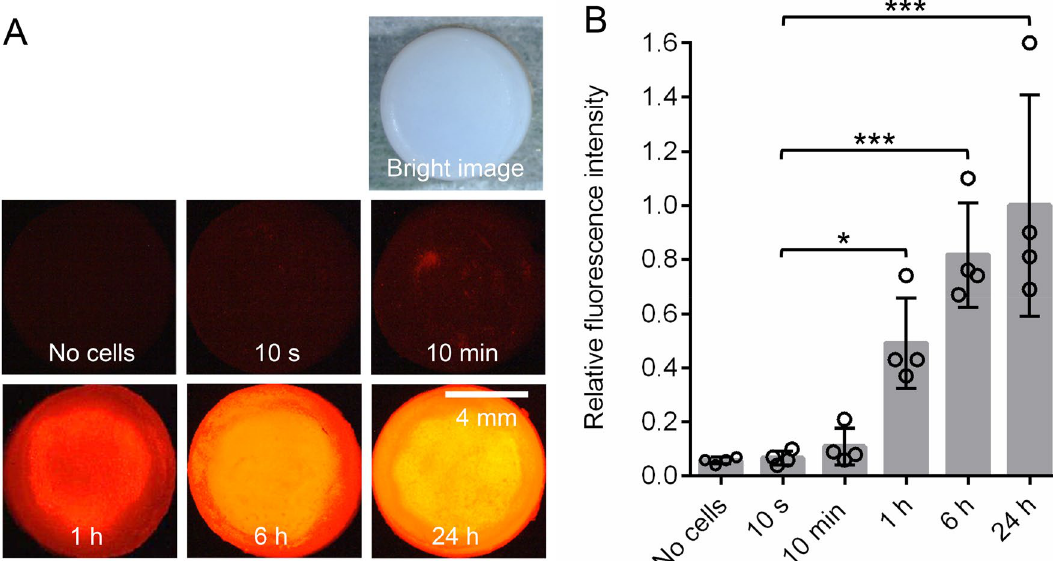
Figure 4. Quantification of adhered MSCs by fluorescence intensity measurements. A DiI-labeled MSC suspension was placed on the porcine abraded cartilage, and the cartilage was washed after a specified time and observed by fluorescence microscopy. ( A ) Fluorescence images. ( B ) Quantification of the fluorescence intensity. Relative intensity is expressed as a ratio to that at 24 h. The number of cylindrical cartilage pieces per MSC donor was 2 or 3. This experiment was repeated four times independently and plotted (* p < 0.05, *** p <